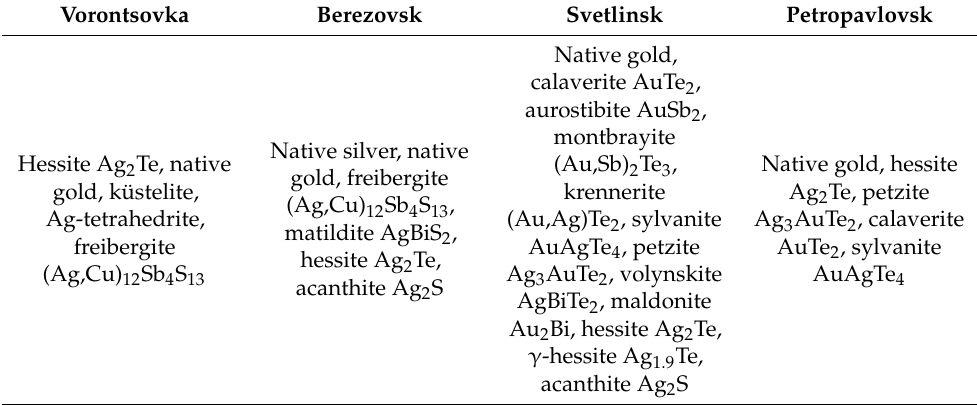
Table 6. Mineral forms of Au and Ag in the large gold deposits of the Urals, modified after